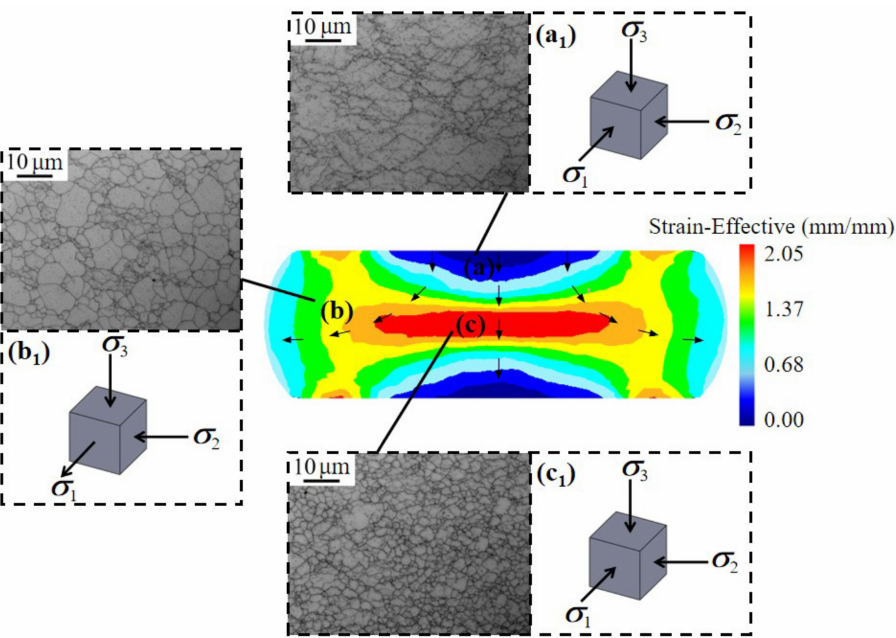
Figure 12. Simulated effective strain field of the specimens after hot deformation at 1100 ◦ C, 0.1 s − 1 , and 70%. ( a ) Difficult deformation region; ( b ) Small deformation region; ( c ) Large deformation region. ( a 1 ) Microstructure of difficult deformation region; ( b 1 ) Microstructure of small deformation region; ( c 1 ) Microstructure of large deformation region.